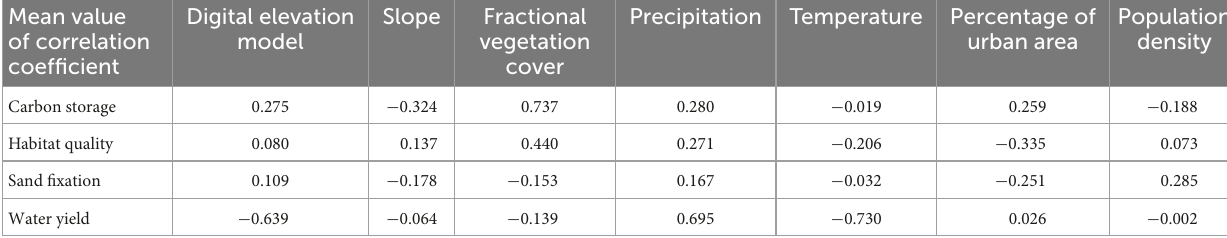
TABLE 4 Mean of regression coefficient of ecosystem services and drivers in the MGWR model. Mean value of correlation